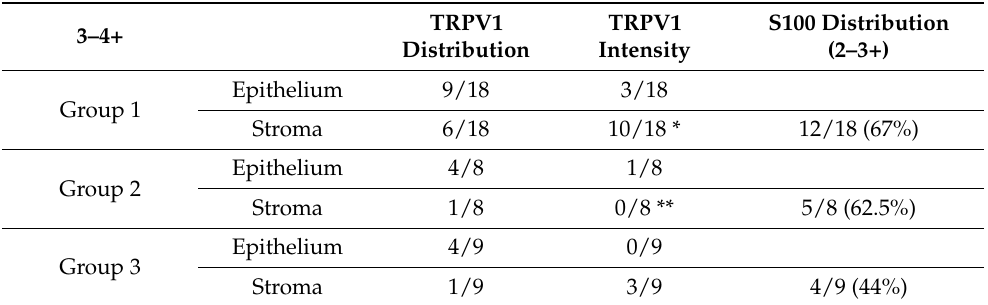
Table 4. Expression. Distribution and Intensity of TRPV1 and S100 in Group 1, 2, 3. * p = 0.035 compared to group 1 epithelium. ** p = 0.0095 compared to group 1 stroma. 3–4+ represents distribution area of 50% and more. 2–3+ represents distribution area of 5–15% for S100